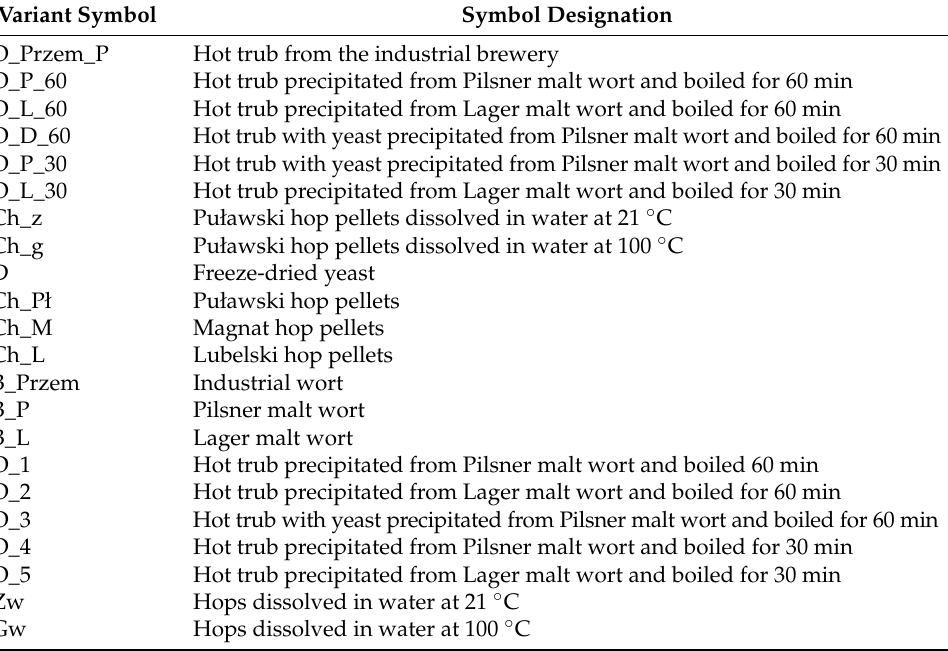
Table 1. List of analyzed